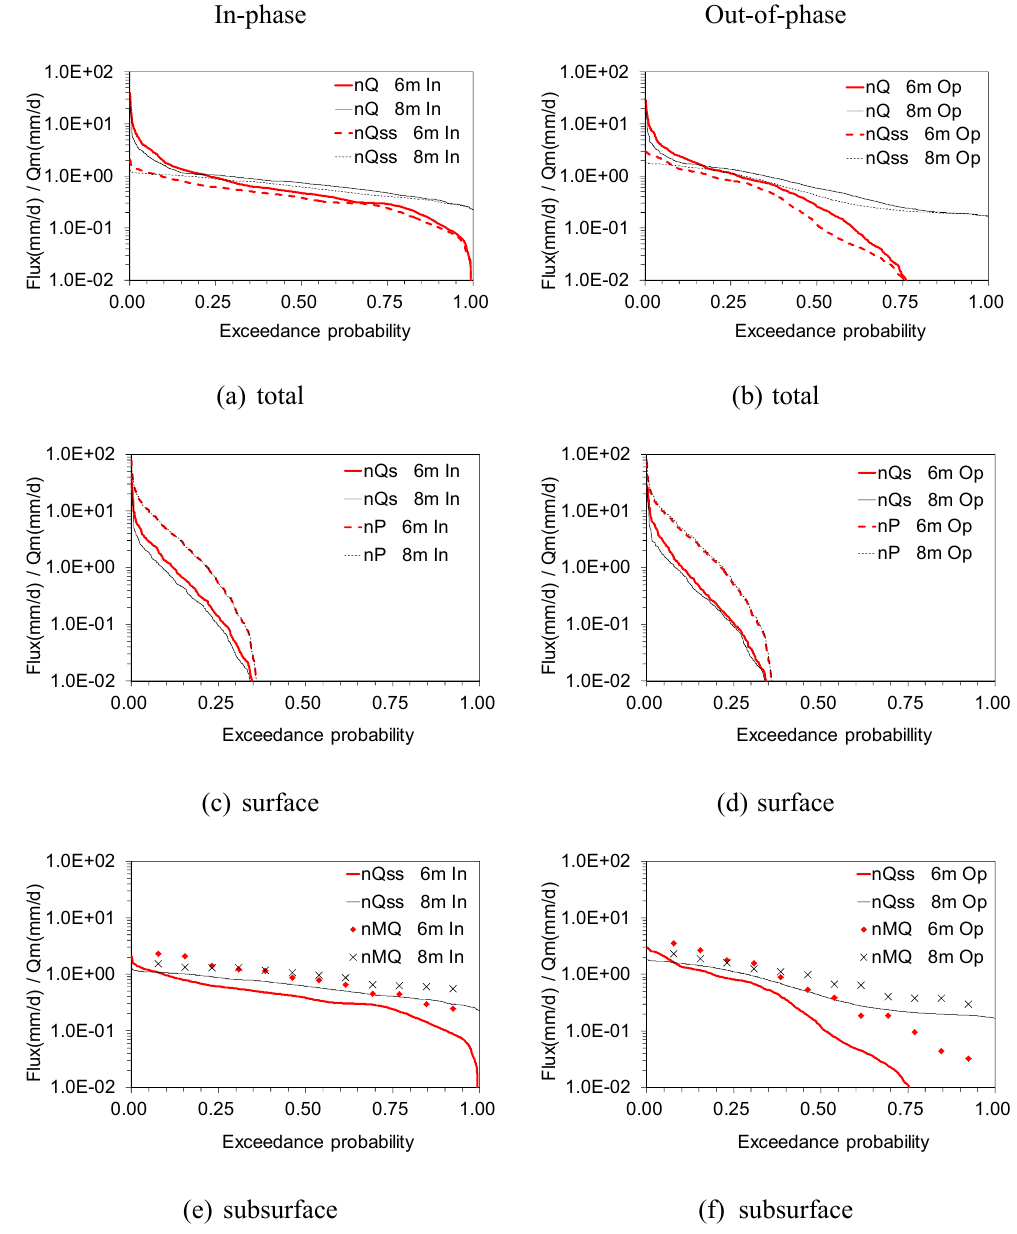
Fig. 5. Effect of soil depth for different climatic seasonality: (a) , (b) : Total flow FDC, (c) , (d) : surface flow FDC, (e) , (f) : subsurface flow FDC. (a) , (c) , (e) : seasonal peaks of P and PET are in phase, (b) , (d) , (f) : seasonal peaks of P and PET are of opposite phase. The “6m” and “8m” indicate soil depth for each experimental case. Q m is mean annual daily flow (mmd − 1 ). “ nMQ ” refers to FDC associated with the regime curve – ensemble averaged mean within-year daily variation normalized by mean annual daily flow Q m . Default value of climate dryness is R =0.5 (humid), soil type is silty loam, and topographic gradient is 0.006.